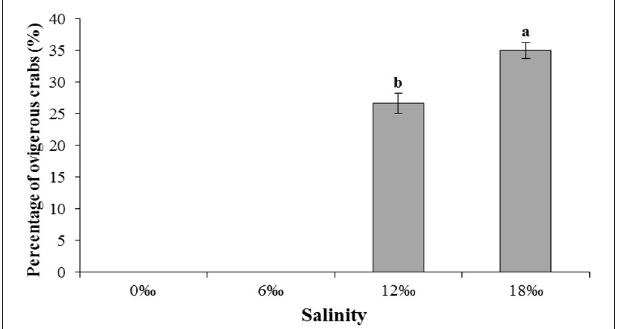
FIGURE 3 | The percentage (%) ( ± SE) of vigorous female E. sinensis subjected to different salinities over 40 days. Different letters on the tops of the bars indicated significant